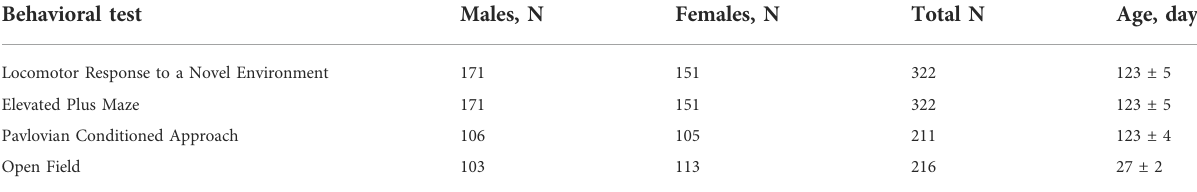
TABLE 1 Number of F 2 rats